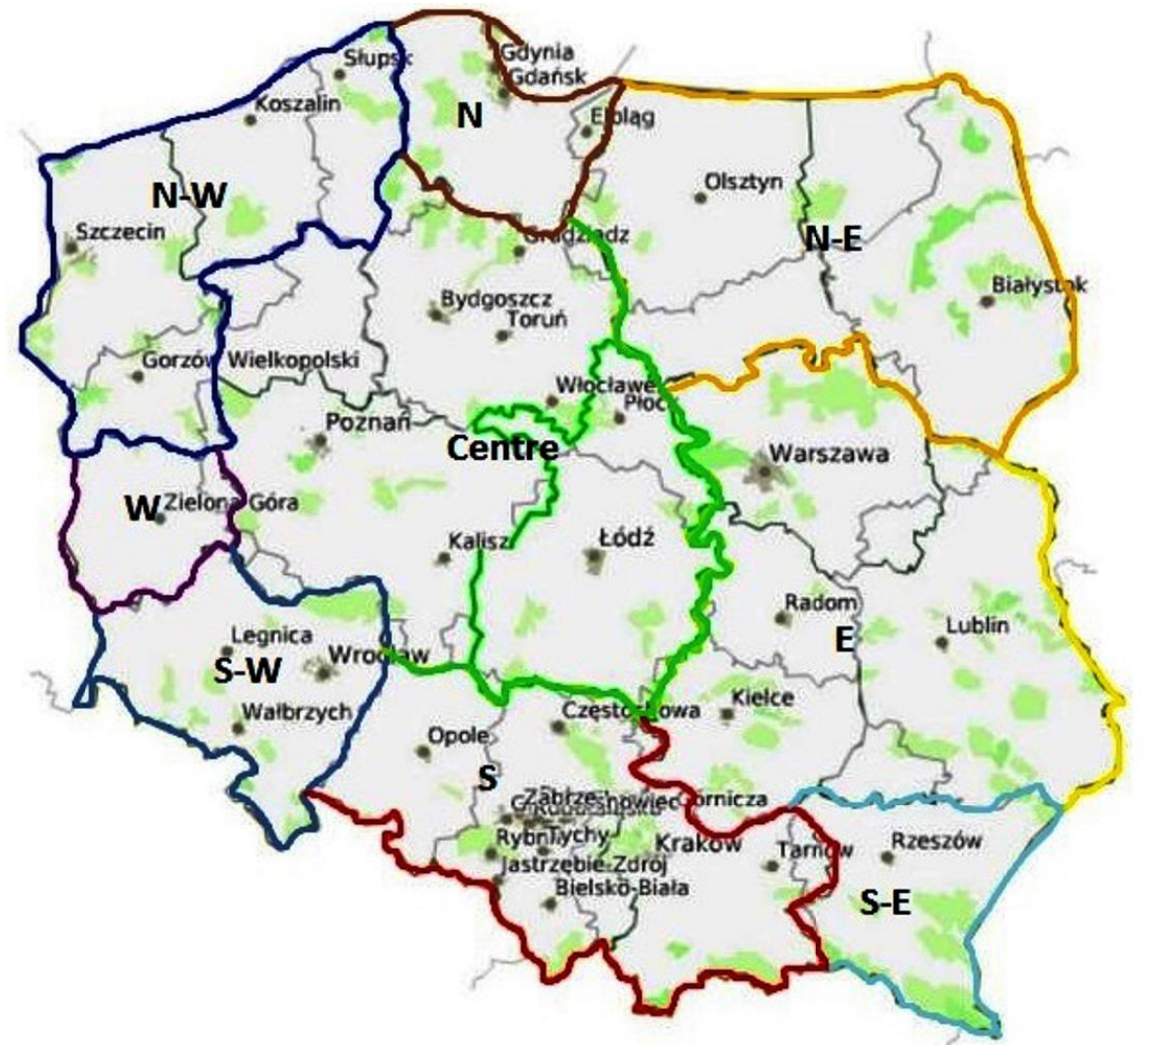
Figure 5. The regional division of biomass production zones in Poland according to geographical directions: N-W — northwest, N — north, N-E — northeast, E — east, Centre, W — west, S-W — southwest, S — south, and S-E — southeast. Source: own elaboration based on the Large-Scale